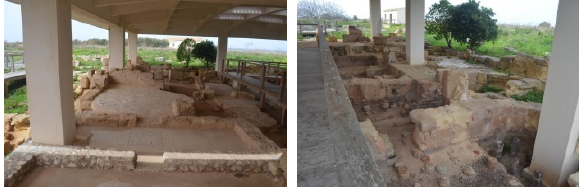
Figure 2. Rooms and thermal baths of the Roman Domus.